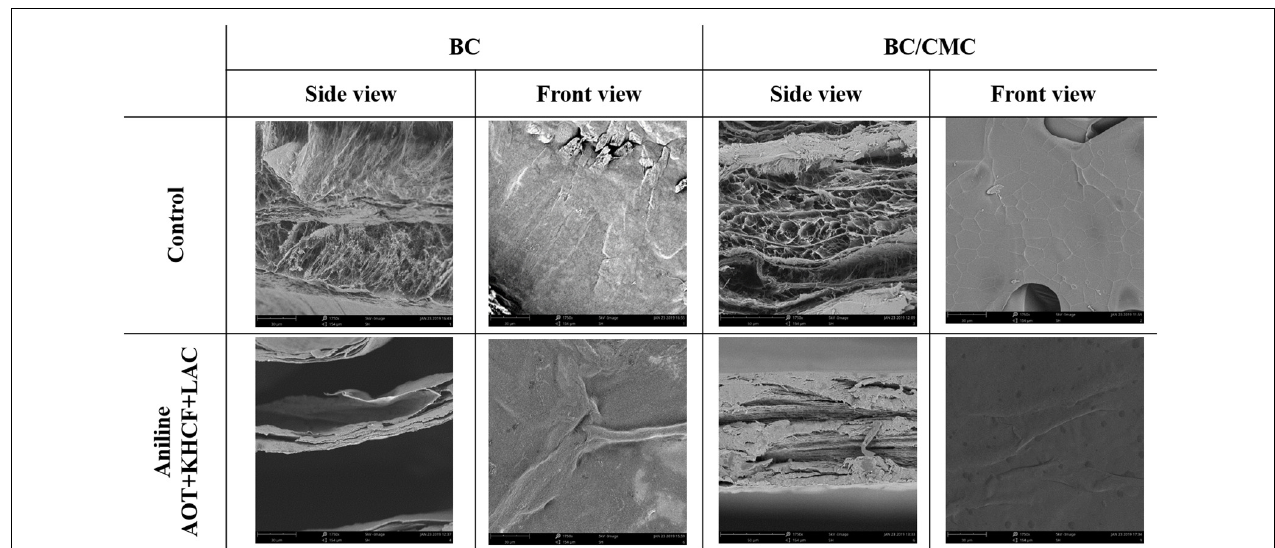
FIGURE 6 | SEM photographs of BC and BC/CMC functionalized with PANi in the presence of laccase and additives ( × 1750 magnification).